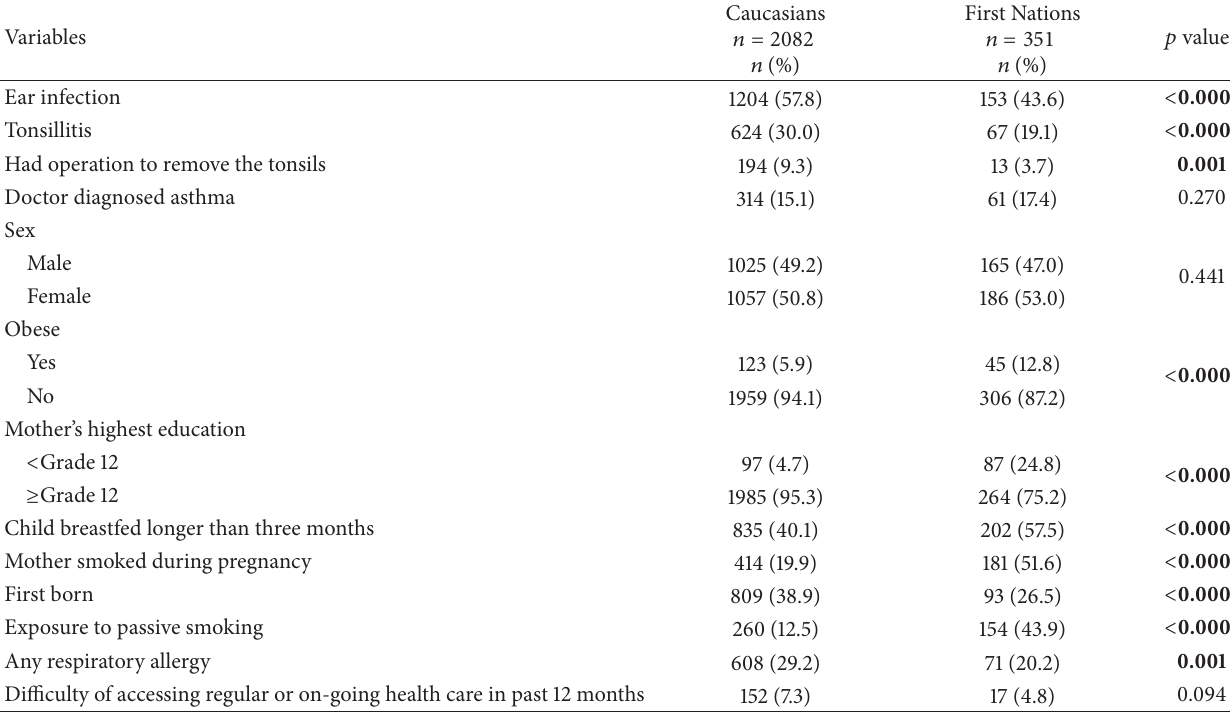
Table 1: Comparison of proportions among Caucasian and First Nations